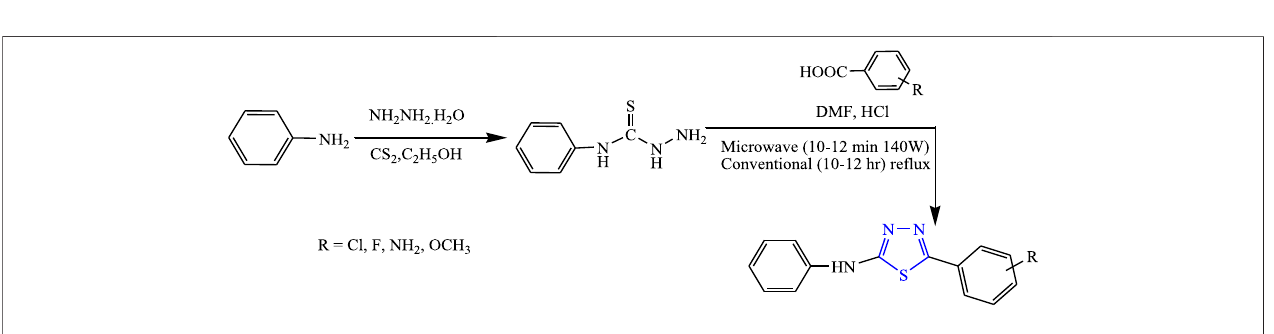
FIGURE 19 | Synthetic pathway for designing phenyl-1,3,4-thiadiazol-2-amine derivatives.